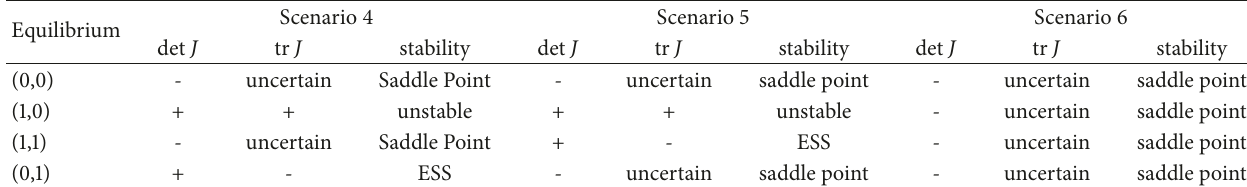
Table 5: Equilibrium point local stability (Scenarios 4, 5, and 6).